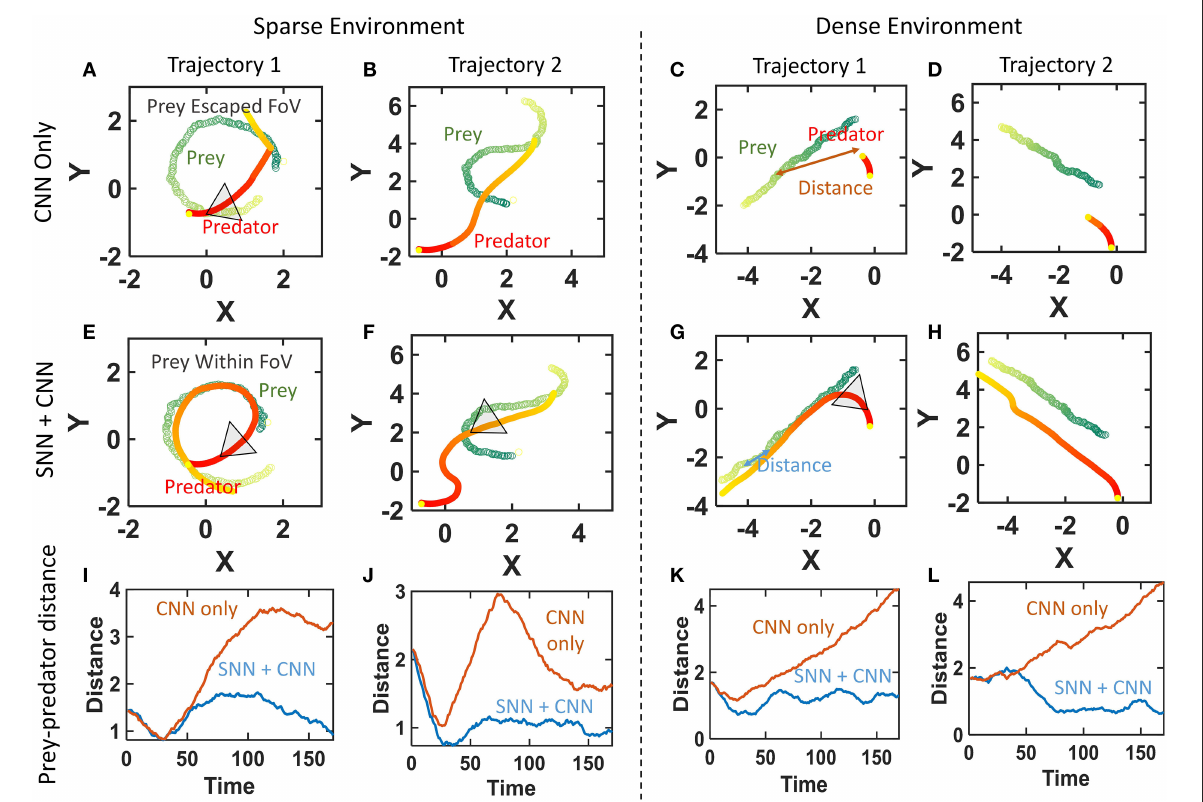
FIGURE6 Performance improvement of the fused (SNN+CNN) system over CNN-only prey chasing for both sparse and dense environments. (A–D) Prey escapes the FoV as CNN throughput cannot keep up with the curvy prey trajectory. (E–H) Fused SNN+CNN tracks the prey using its higher speed while maintaining accuracy. (I–L) Distance between prey and predator diverges for CNN-only chasing while remaining low for the SNN+CNN